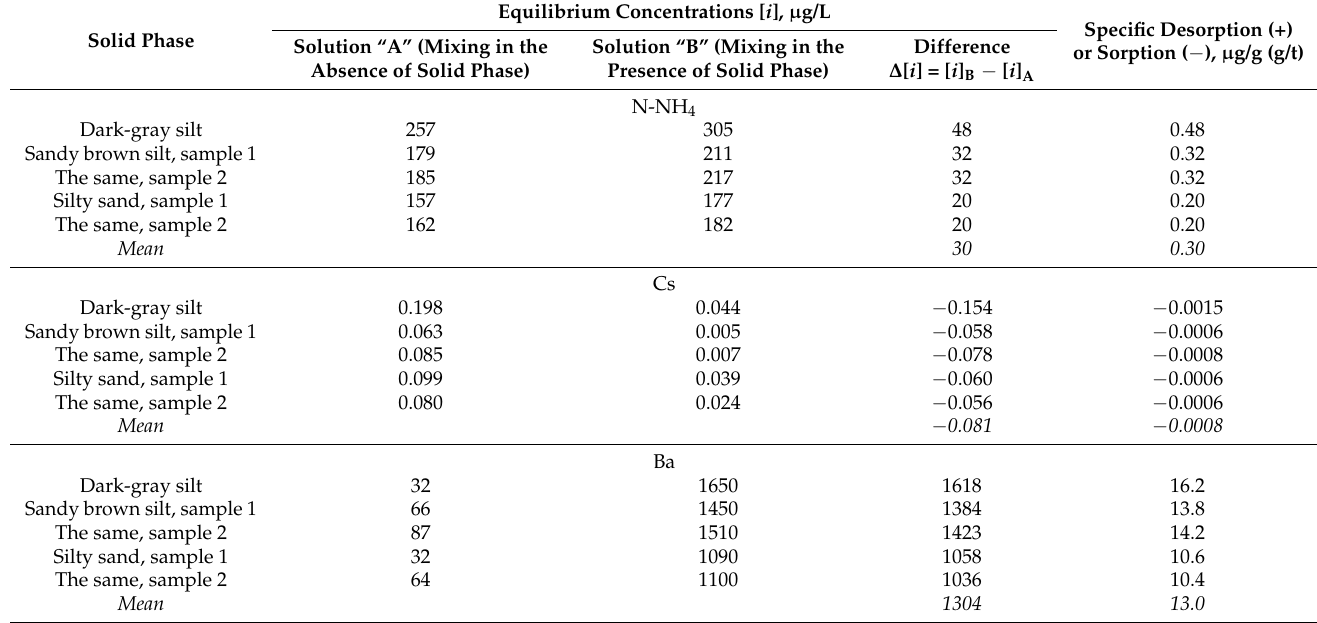
Table 4. Sorption–desorption balance of dissolved trace elements at the interaction of freshwater terrigenous material with seawater 1